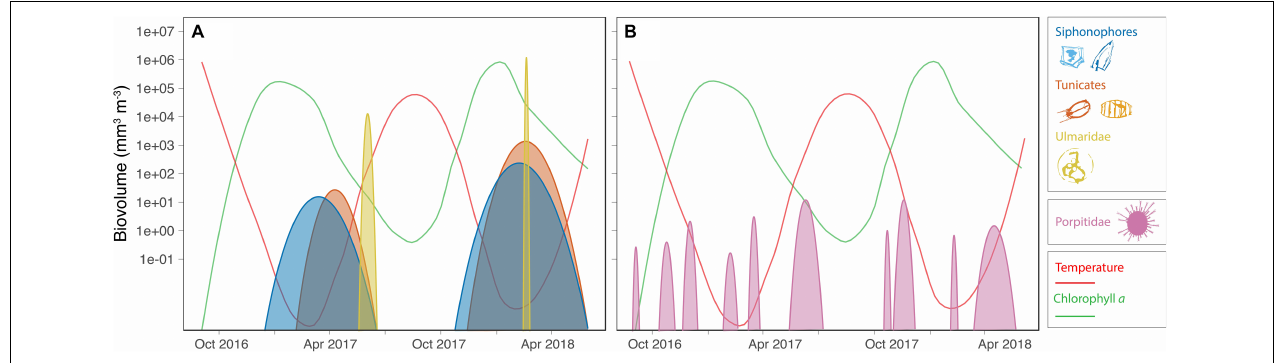
FIGURE 4 | A summary of (A) seasonal blooming dynamics of main groups gelatinous zooplankton taxa (i.e., tunicates, siphonophores, Ulmaridae) and relative dynamics of temperature ( ◦ C) and chlorophyll a ( µ g L − 1 ) found during the study period, and (B) rapid short-term fluctuations showed by Porpitidae and relative dynamics of temperature ( ◦ C) over the study period. Maximums are taken from maximum observations from the data, centered at the day at which the maximums where found, and limits represent the first time point at which individuals were observed and stopped being